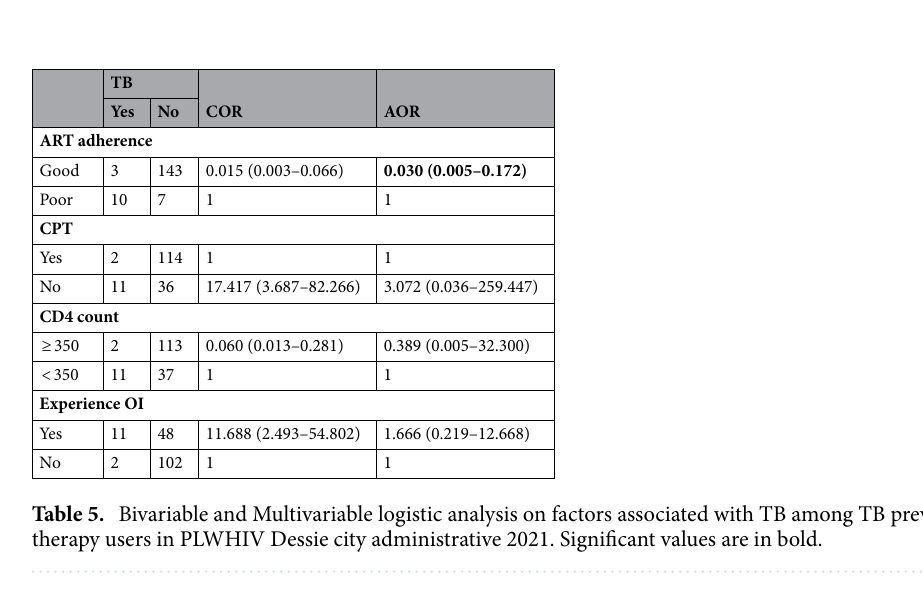
Table 4. Bivariable and multivariable logistic analysis of factors associated with TB among PLWHIV nonusers of isoniazid preventive therapy for TB in Dessie city administrative 2021. Significant values are in bold.